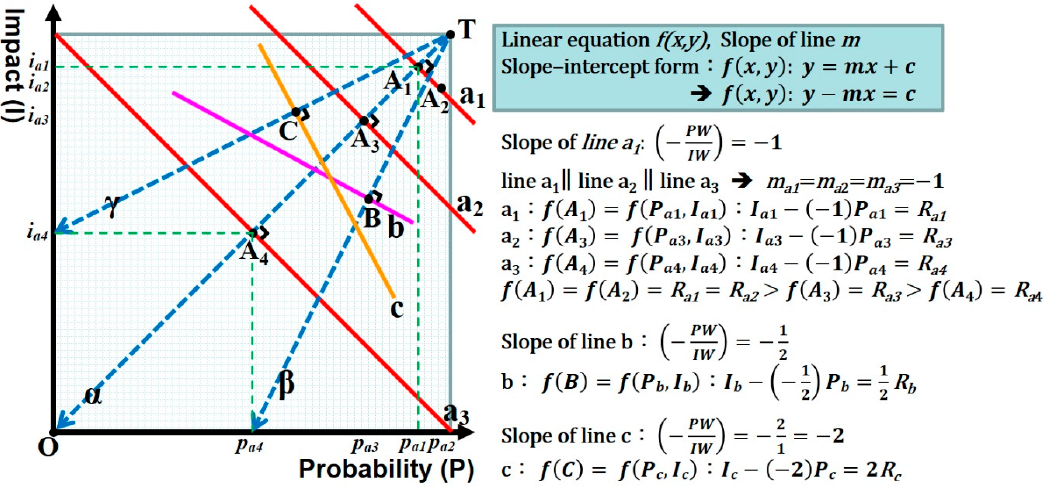
Figure 5. Different linear equations of different Impact and Probability weighting ratios. Figure 5. Di ff erent linear equations of di ff erent Impact and Probability weighting